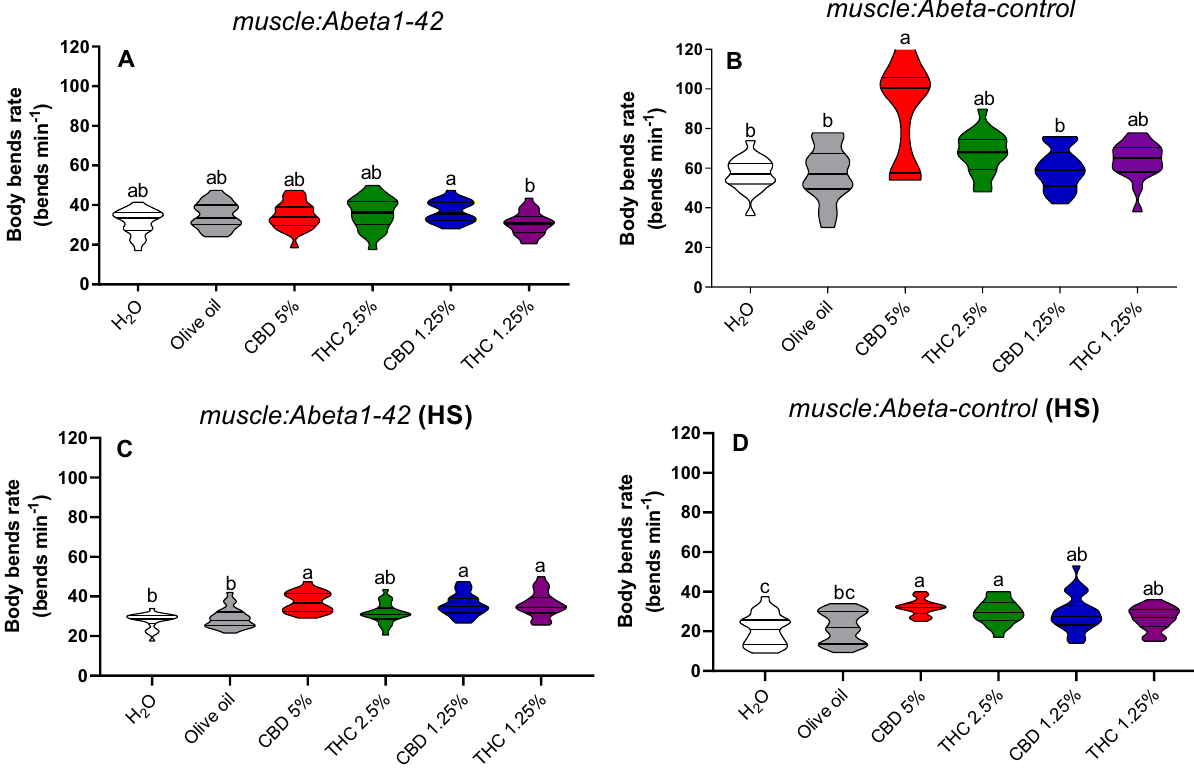
Figure 5. Body bends rate in non-stressed ( A , B ) and heat-stressed (HS) ( C , D ) C. elegans muscle:Abeta1-42 and muscle:Abeta-control transgenic strains. Data are expressed by the mean ± standard error (SEM). Means followed by the same letter are not significantly different according to Tukey’s test ( p > 0.05) ( A , C ) or Dunn’s test ( p > 0.05) ( B , D